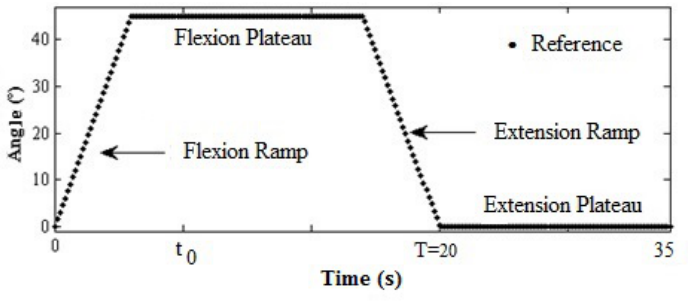
Figure 2 - Graphic of the reference signal and its